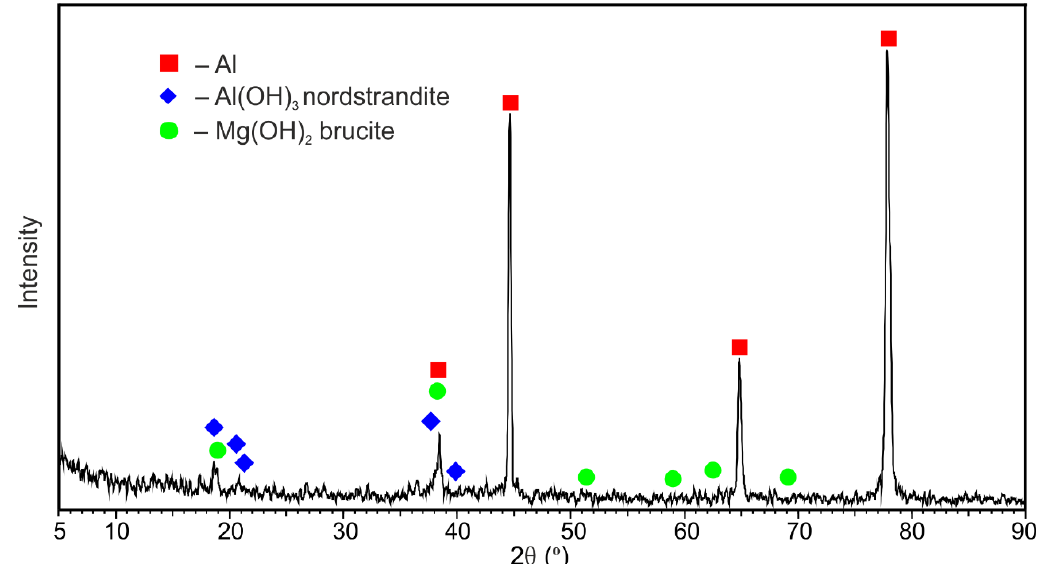
Figure 5. XRD pattern of the 1579 aluminium alloy sample after 30 days of immersion experiments in a 0.5 M NaCl solution. This figure shows peaks which identify Al(OH) 3 and Mg(OH) 2 in the composition of the corrosion products.